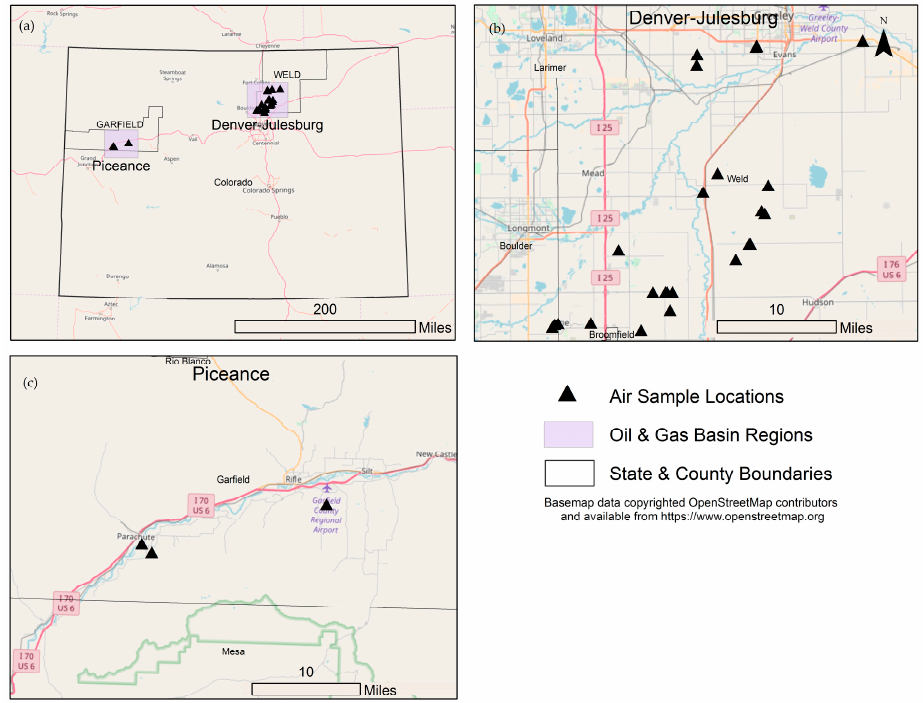
Figure 3. Air sample collection locations ( a ) within the two major oil and gas basins in Colorado, the ( b ) Denver-Julesburg Basin and ( c ) Piceance Basin. Table 1 provides details on individual air datasets.